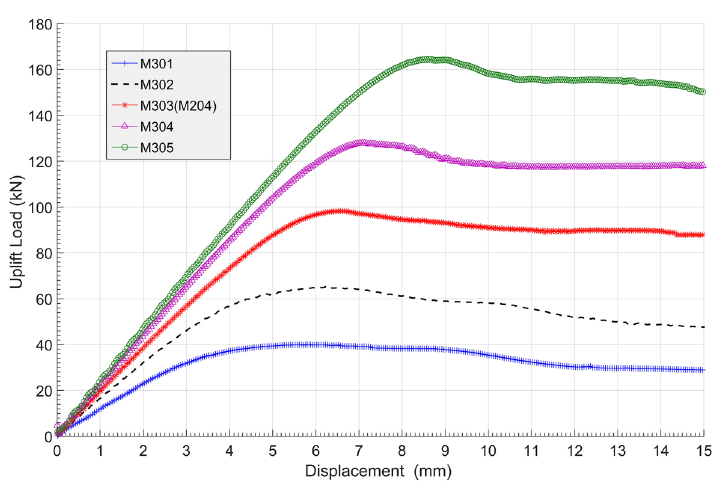
Figure 19. Load–displacement curves of group